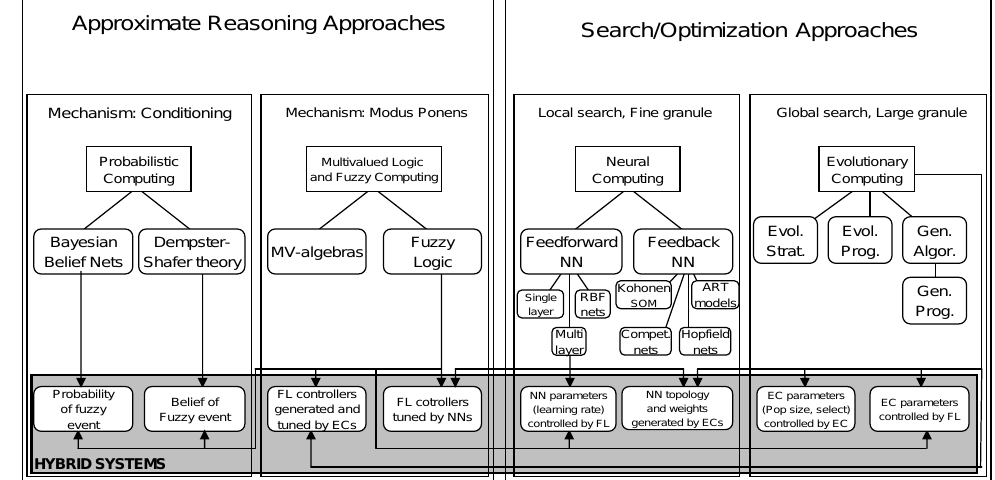
Fig. 1. Hybridization in Soft Computing according to Bonissone et al. 3 .